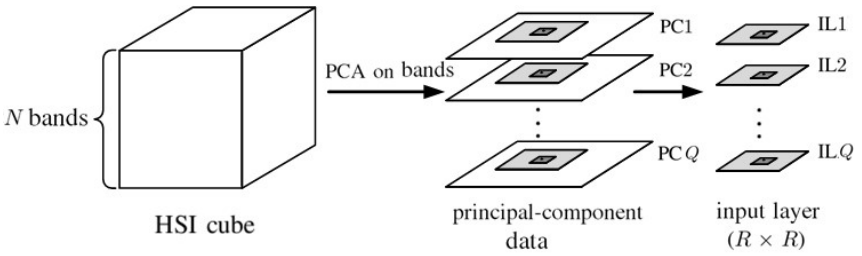
Figure 9. Preparation of input layers for 2D-CNN.